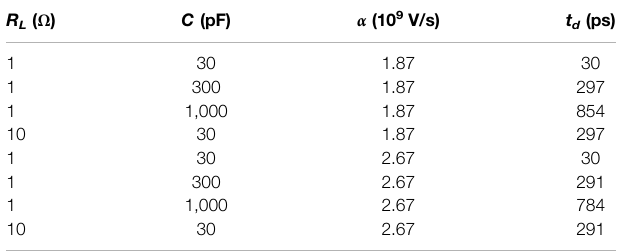
TABLE 2| Delaytime t d asafunctionofthelumpedelements of Figure 1 .Symbol α indicates the slope of the ramp (see